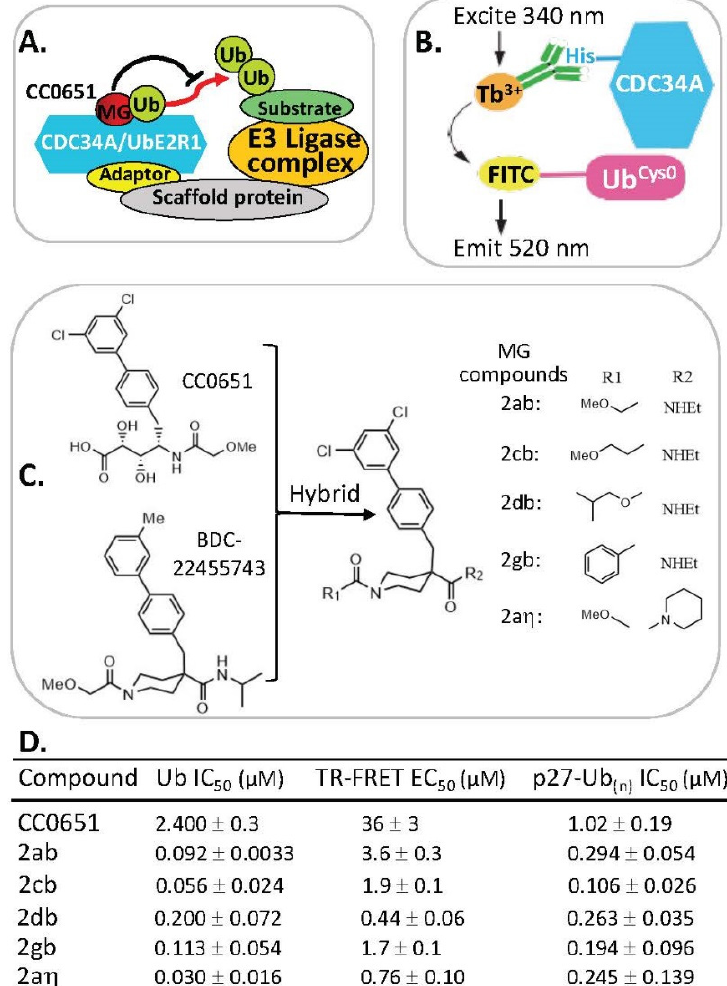
Figure 9. ( A ) Cartoon models of CDC34A and E3 ligase-mediated substrate ubiquitination being blocked by MG CC0651 (i.e., inhibition of ubiquitin transfer by stabilizing the noncovalent CDC34A- donor ubiquitin complex); ( B ) schematic of TR-FRET assay to detect CDC34A/UbE2R1–ubiquitin interactions. The assay used an N-terminal His-tagged CDC34A for recognition by an anti-His6 antibody coupled to Tb3+ and an N-terminal cysteine mutant of ubiquitin (denoted UbCys0) stoichiometrically labeled with 5 ′ -iodoacetamide-fluorescein. In response to titration with CC0651, excitation of Tb3+ at 340 nm resulted in fluorescence energy transfer to the fluorescein moiety and emission at 520 nm; ( C ) diagram to explain the led compounds 2ab, 2cb, 2db, 2gb, and 2a η generated by medicinal chemistry hybridization of the prototype compound CC0651 and the isonipecotamide hit BDC22455743; ( D ) Ub IC 50 (µM), TR-FRET EC 50 (µM), and p27-Ub (n) IC 50 (µM) for the prototype compound CC0651 and the led compounds 2ab, 2cb, 2db, 2gb, and 2a η were shown. IC 50 values represent the mean +/ − variance, n = 2. EC 50 values represent the mean +/ − SD, n = 3. ( B , D ) are adapted from an original paper by St-Cyr et al. (some information is also from their provided supplemental materials)